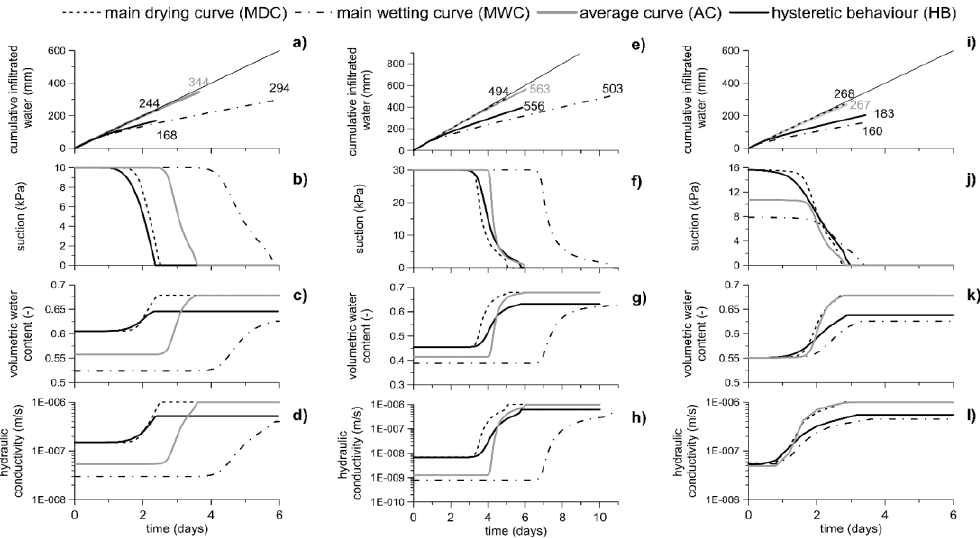
Figure 9. Results of analyses conducted up to suction vanishing at a depth of 1.5 m. First row : cumulative infiltrated water (dotted black line: cumulated rainfall). Second row : suction evolution. Third row : volumetric water content evolution. Fourth row: hydraulic conductivity evolution. First column : hydrostatic initial condition with 10 kPa at 1.5 m. Second column : hydrostatic initial condition